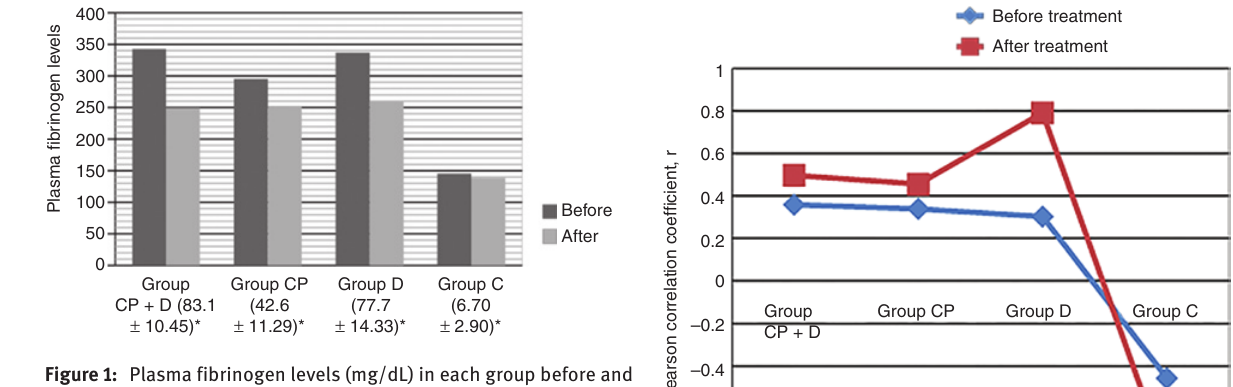
Figure 1: Plasma fibrinogen levels (mg/dL) in each group before and after treatment (mean ± SD values are shown).